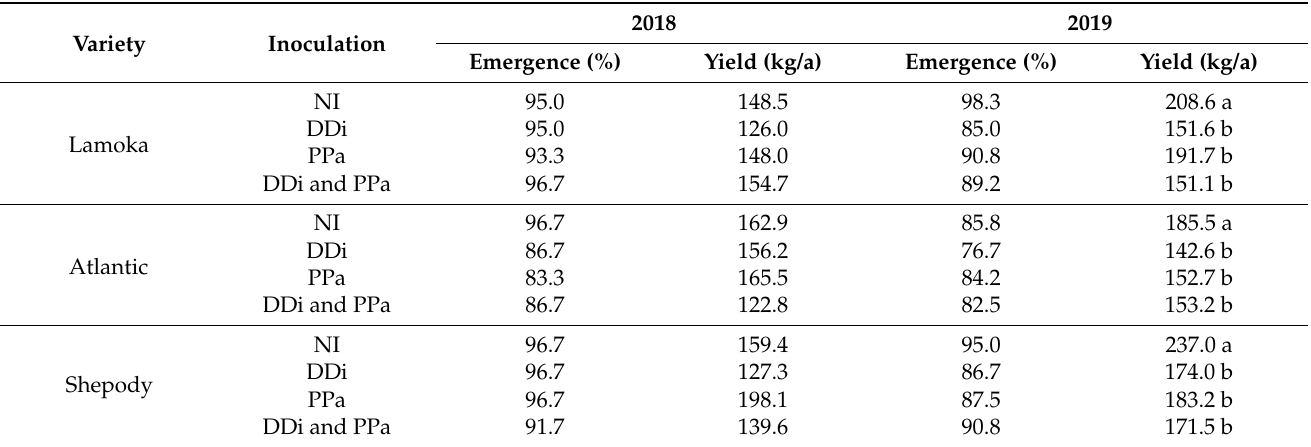
Table 4. Effects of seed tuber inoculation with Dickeya dianthicola (DDi), Pectobacterium parmentieri (PPa) and non- inoculated (NI) on emergence and yield of potato varieties in years 2018 and